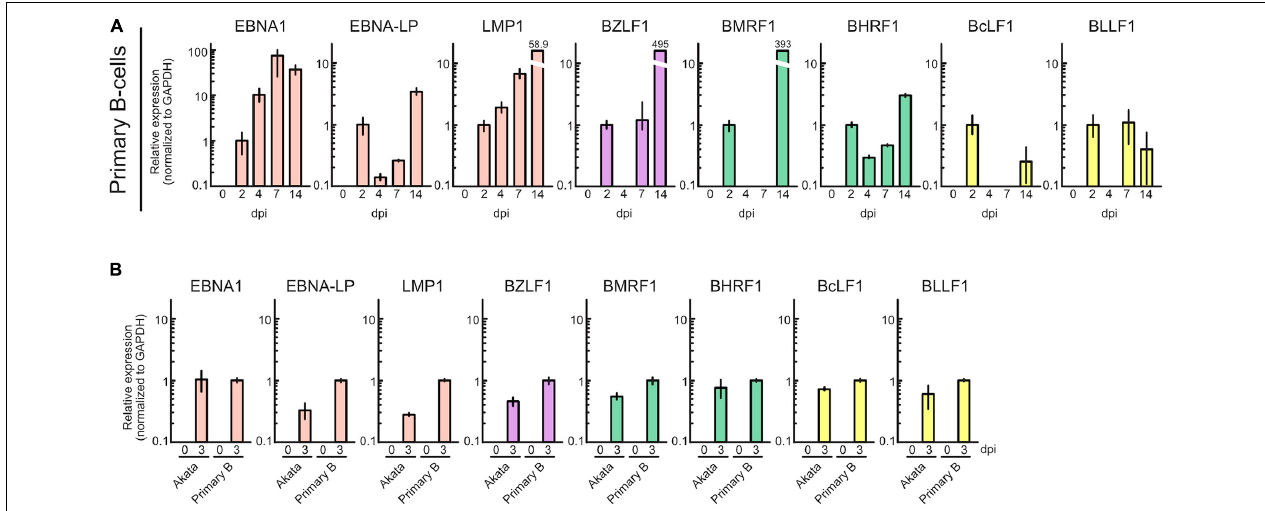
FIGURE 3 | Profile of EBV gene expression in the pre-latent phase of EBV infection of primary B-cells. (A) Purified primary B-cells were infected with EBV-EGFP and harvested at 0, 2, 4, 7, or 14 dpi. EBV gene expression was assessed by qRT-PCR and normalized to GAPDH expression. Results are presented as means ± SD of three independent experiments and are shown relative to gene expression at 2 dpi. (B) Akata(–) or purified primary B-cells were infected with EBV-EGFP and harvested at 0 and 3 dpi. EBV gene expression was assessed by qRT-PCR and normalized to GAPDH expression. Results are presented as means ± SD of three independent experiments. Abbreviations: dpi, day post-infection.